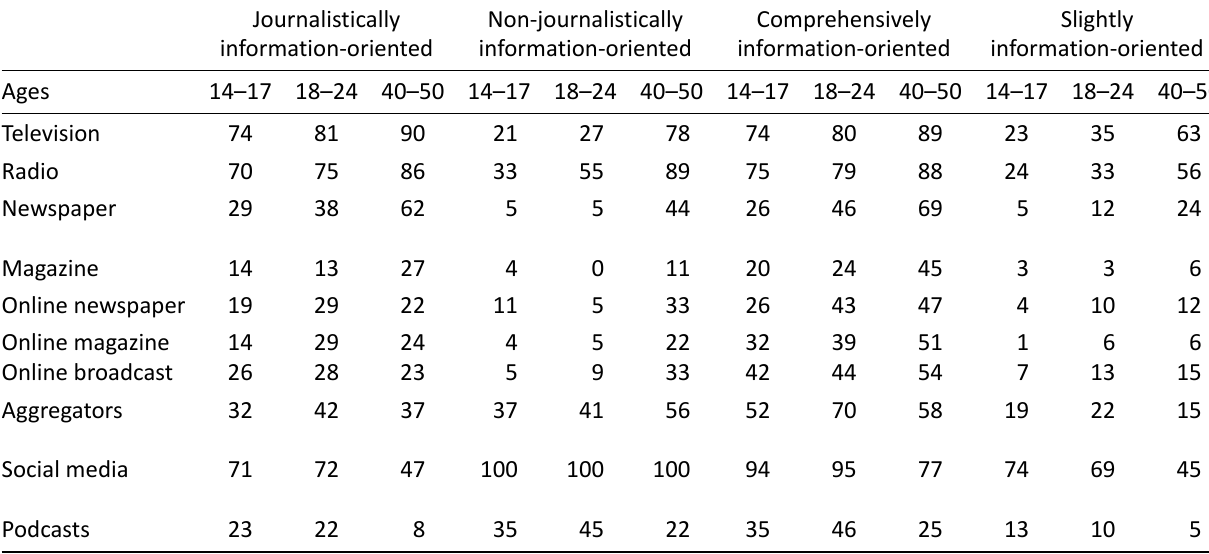
Table 1. Types of information orientation and daily sources for information, in %. Journalistically Non‐journalistically Comprehensively Slightly information‐oriented